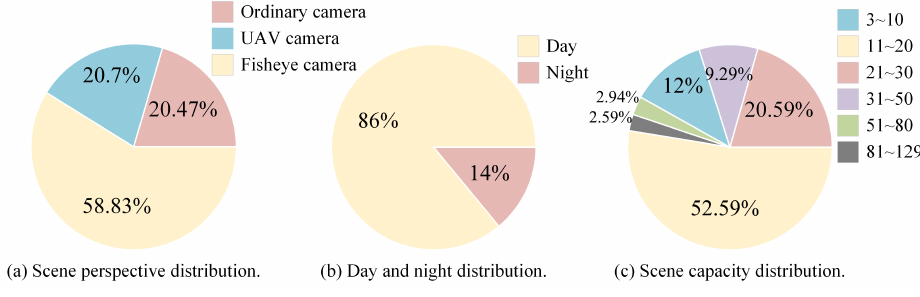
Figure 4. Representative samples of the images in the collected pasture dataset.